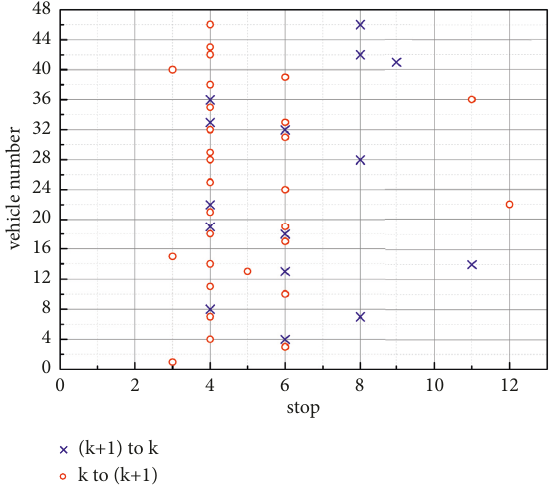
Figure 7: Synchronization distribution